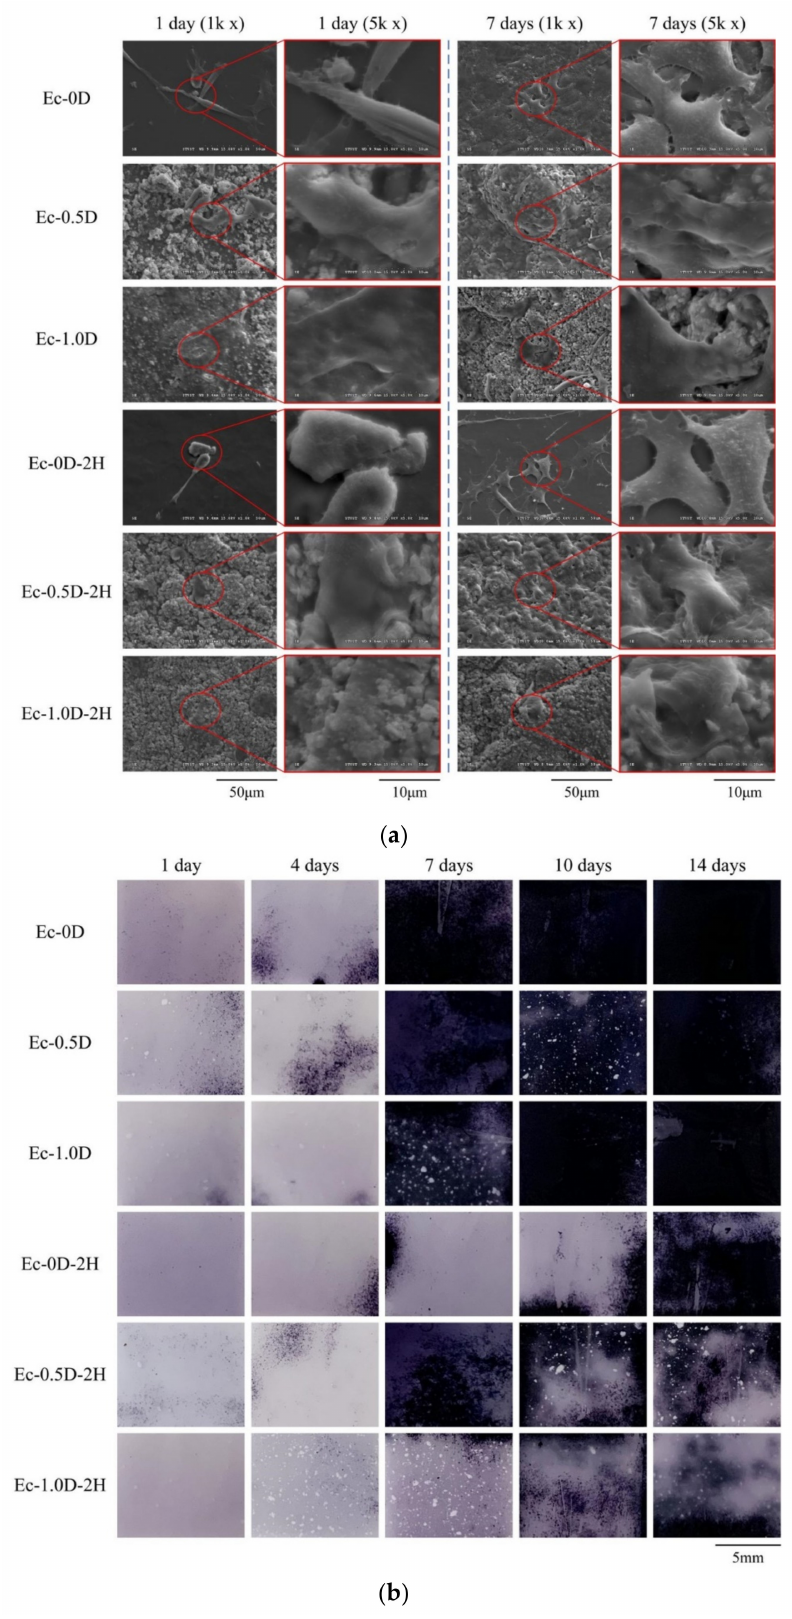
Figure 12. Images of cell attachment on the hydrogel membranes in contact with D1 cells for 1 day and 7 days ( a ) and ALP staining of the hydrogel membranes in contact with D1 cells and cultured for 1, 4, 7, 10, and 14 days ( b